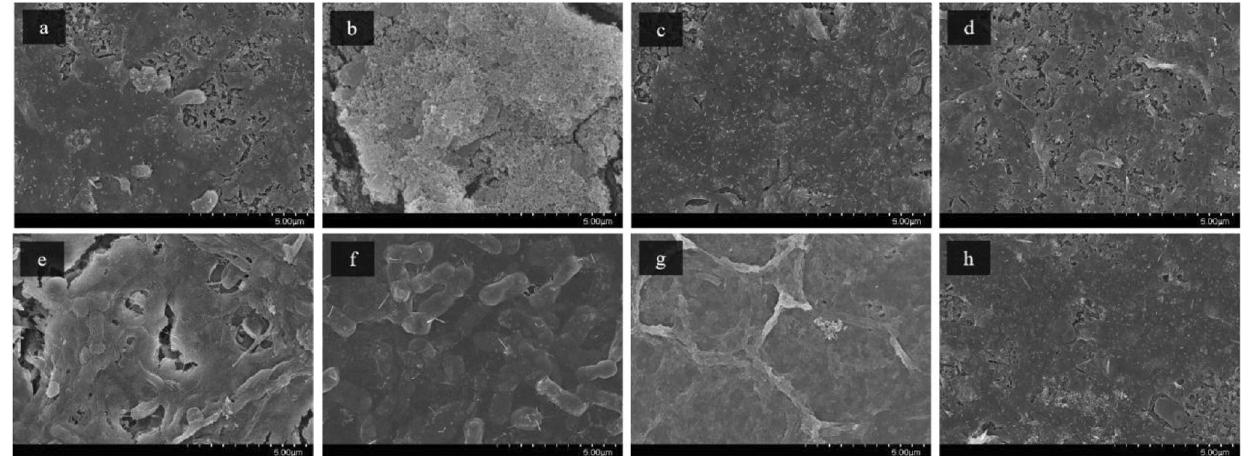
Fig. 4 Scanning electron microscope (SEM) images of DRB bio fi lms. SEM images of DRB bio fi lms developed on the surface of RO membranes was taken by fi eld-emission scanning electron microscopy. a control group, b K 2 FeO 4 group, c O 3 group, d NH 2 Cl group, e FES group, f UV group, g NaClO group, and h ClO 2